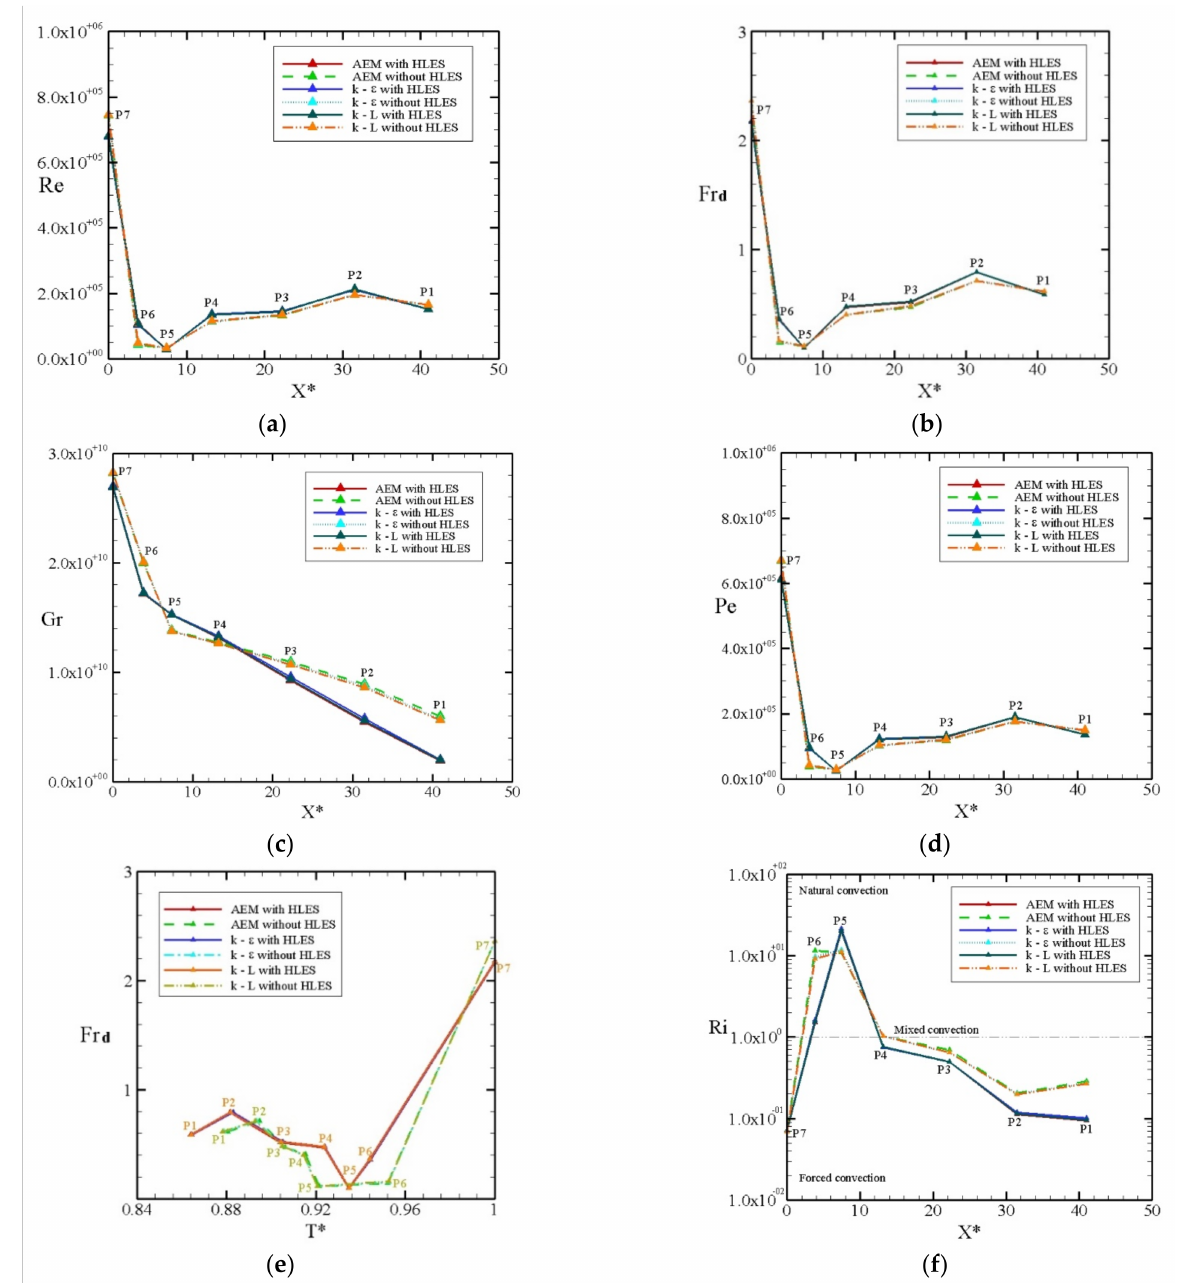
Figure 13. Evolution from P7 to P1 of the dimensionless numbers computed at the free surface for the turbulence closure models considered: ( a ) R e ; ( b ) F rd ; ( c ) G r ; ( d ) P e ; ( e ) F rd vs. T ∗ ; ( f ) R i